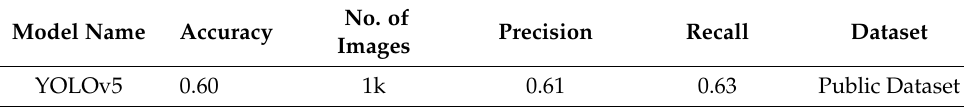
Table 6. YOLOv5 on public dataset.